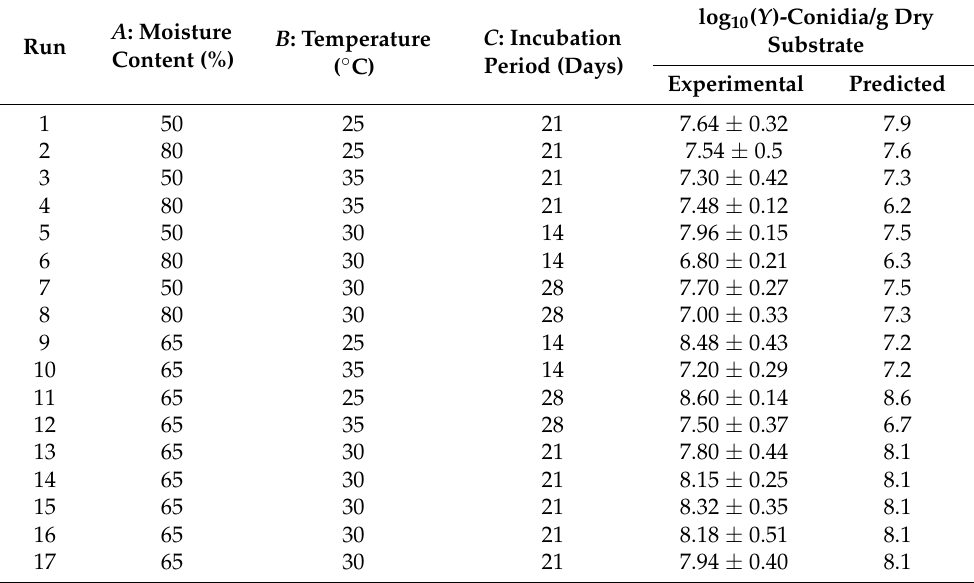
Table 5. BBD matrix together with the experimental and predicted values for optimization of biomass production using T. asperellum AU131.